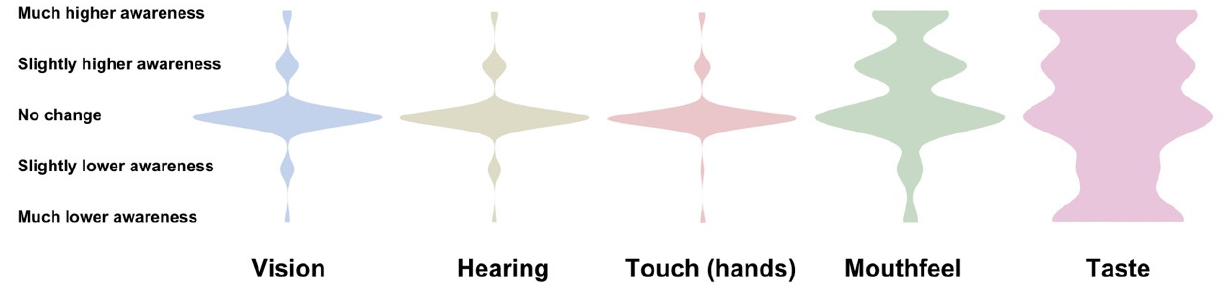
Figure 3. Changed awareness of other senses following olfactory